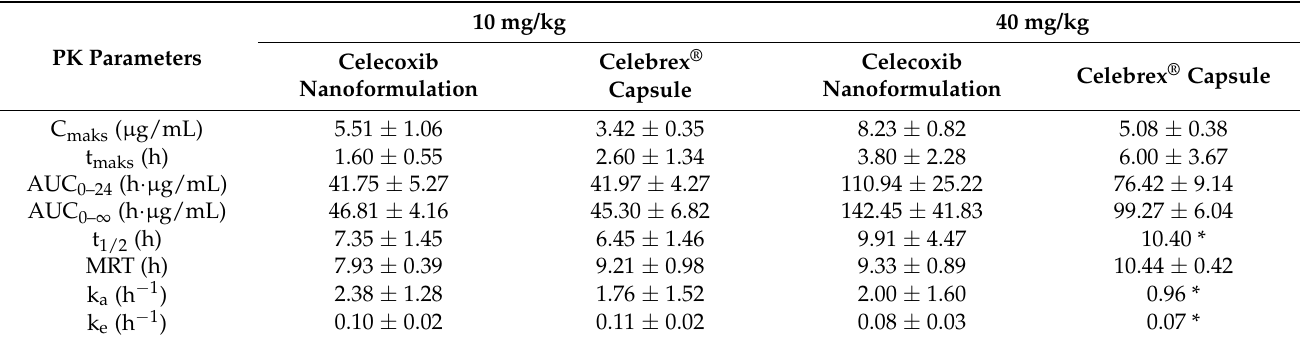
Table 9. Pharmacokinetic parameters of CXB nanoformulation and Celebrex ® capsule after oral administration in rats (n = 5, mean ±